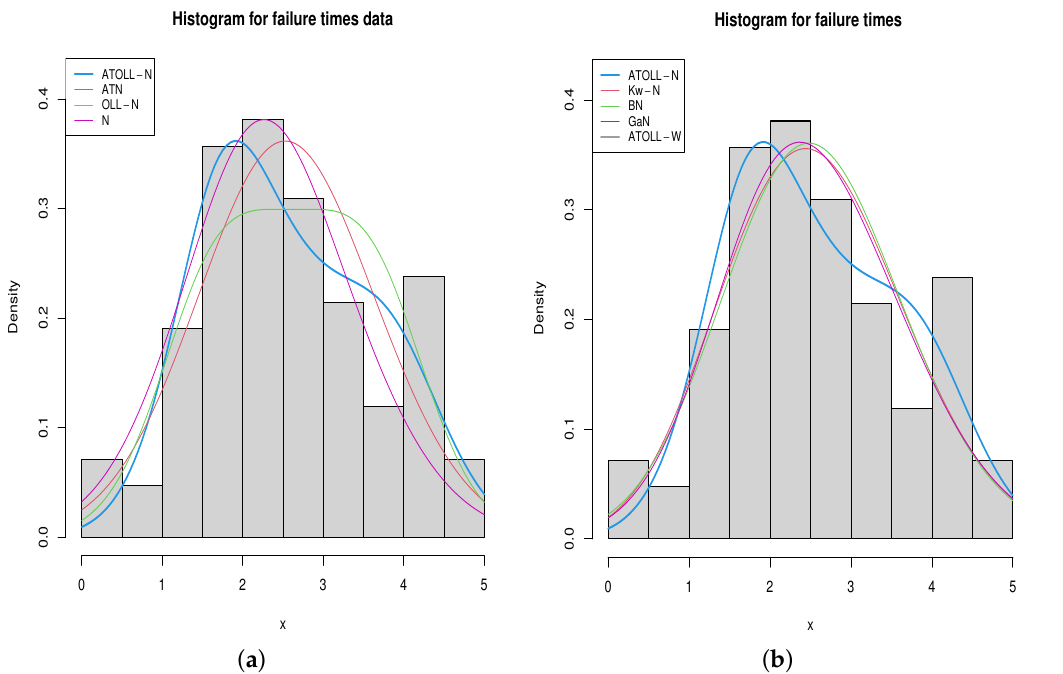
Figure 8. Histogram and density plots for failure times data. Plots for ( a ) sub-models and ( b ) oth- ers models.